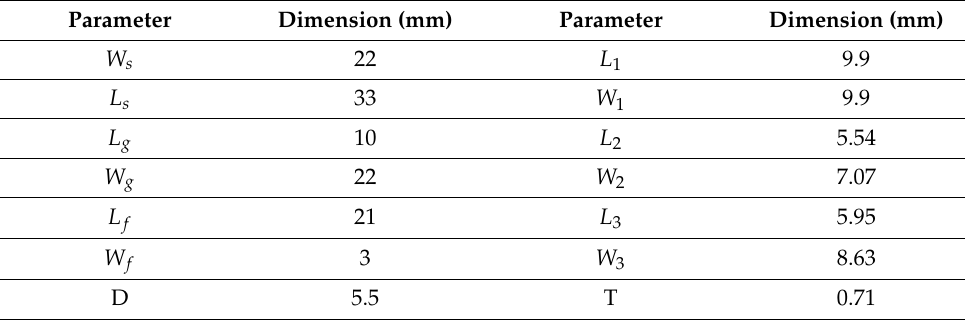
Figure 8. The effect of the distance between the two rings on the reflection coefficient of the pro- posed antenna. Table 3. The optimized parameters of the proposed antenna.